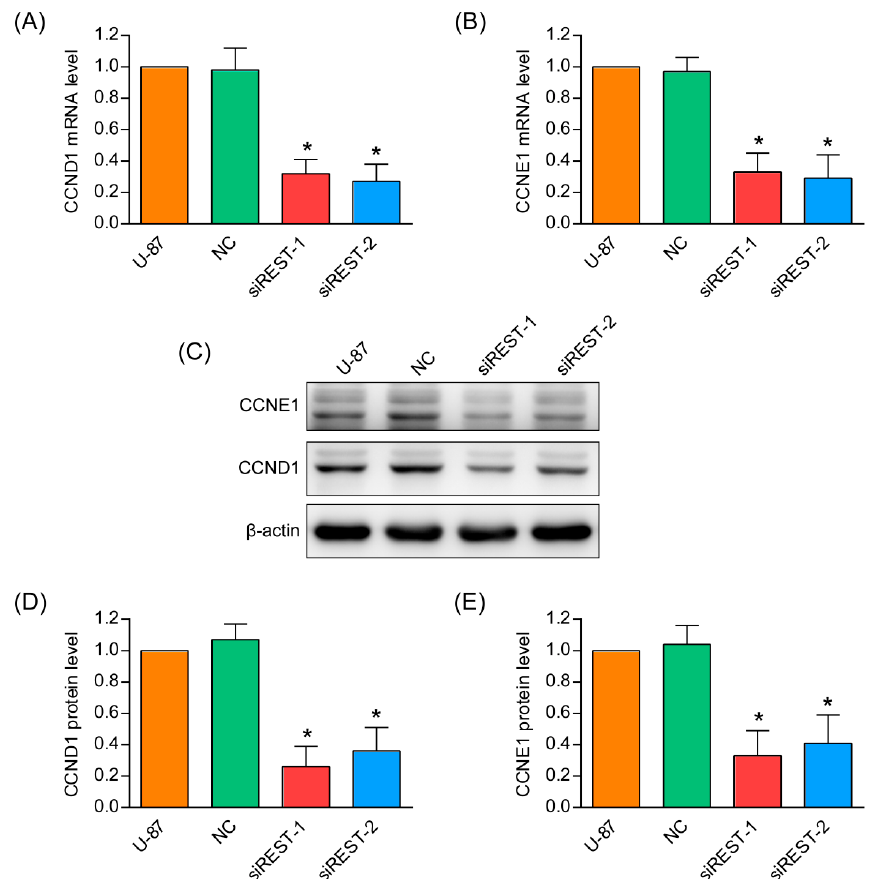
Figure 4. CCND1 and CCNE1 were reduced by REST knockdown. ( A , B ) The mRNA levels of two genes involved in G1–S cell cycle transition, CCND1 and CCNE1 were analyzed by real-time PCR; ( C ) The expression of CCND1 and CCNE1 was verified by Western blotting; ( D , E ) The quantifications of Western blotting were applied with Image J. * p < 0.05 compared with NC group.